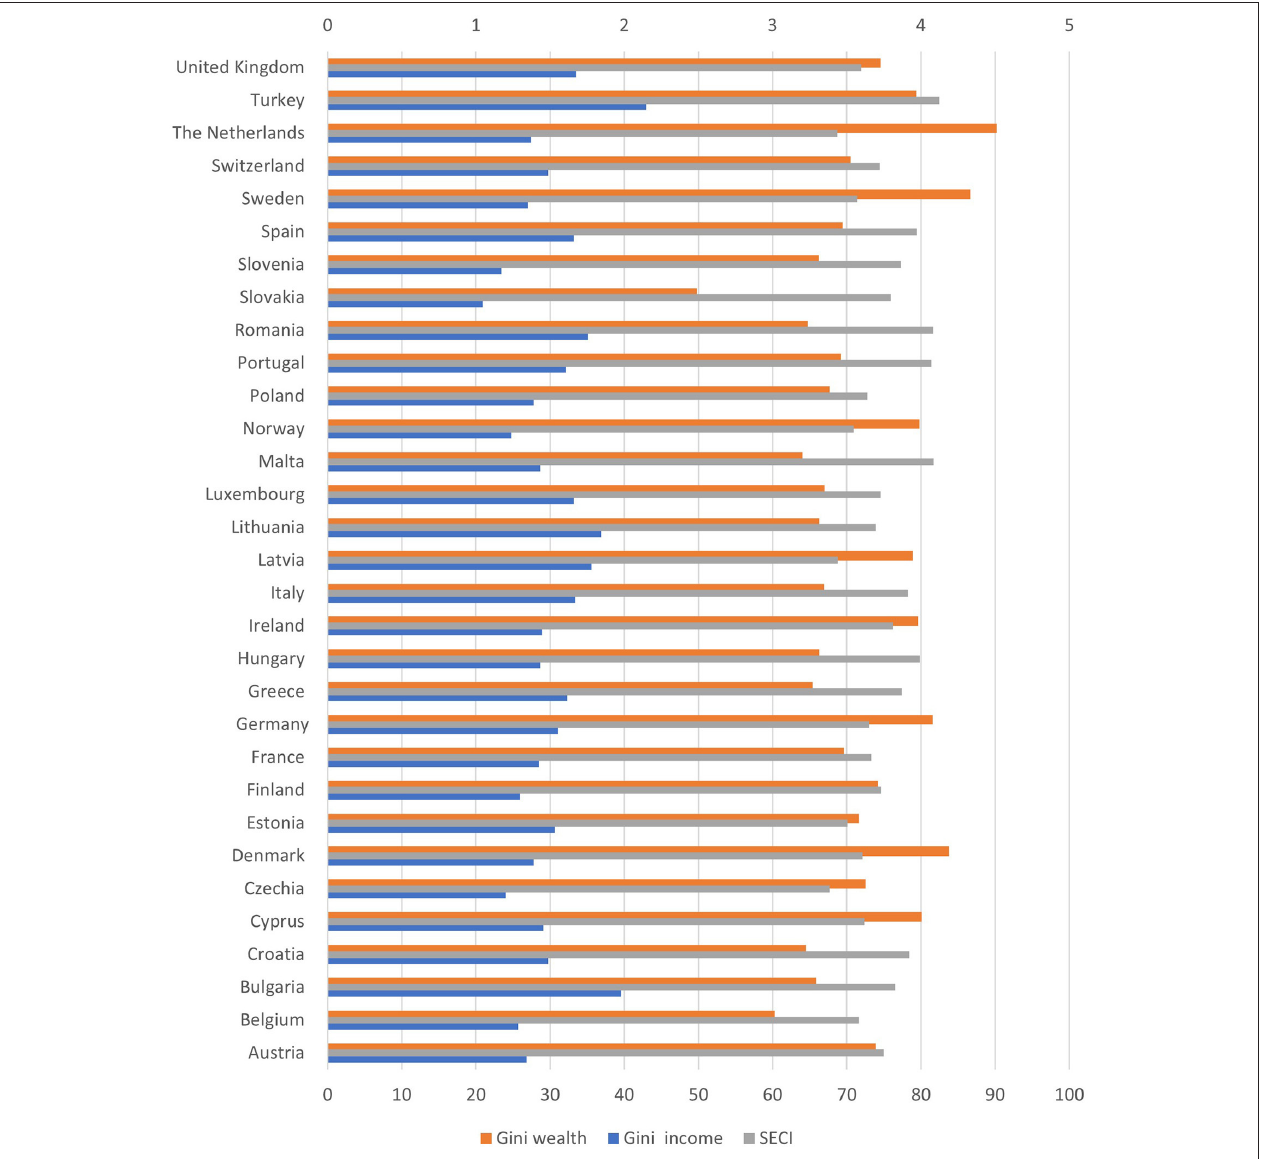
FIGURE 1 | Gini wealth index, Gini income index, and SECI score for European